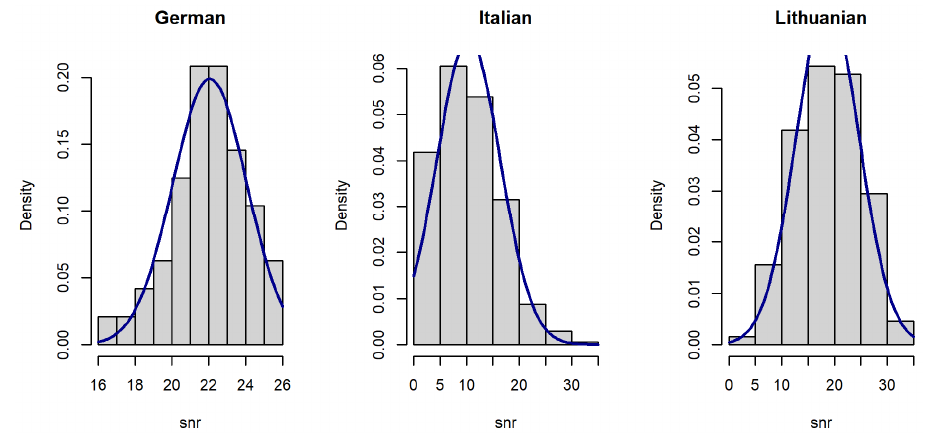
Figure 3. Histograms of voice signal SNR in datasets.